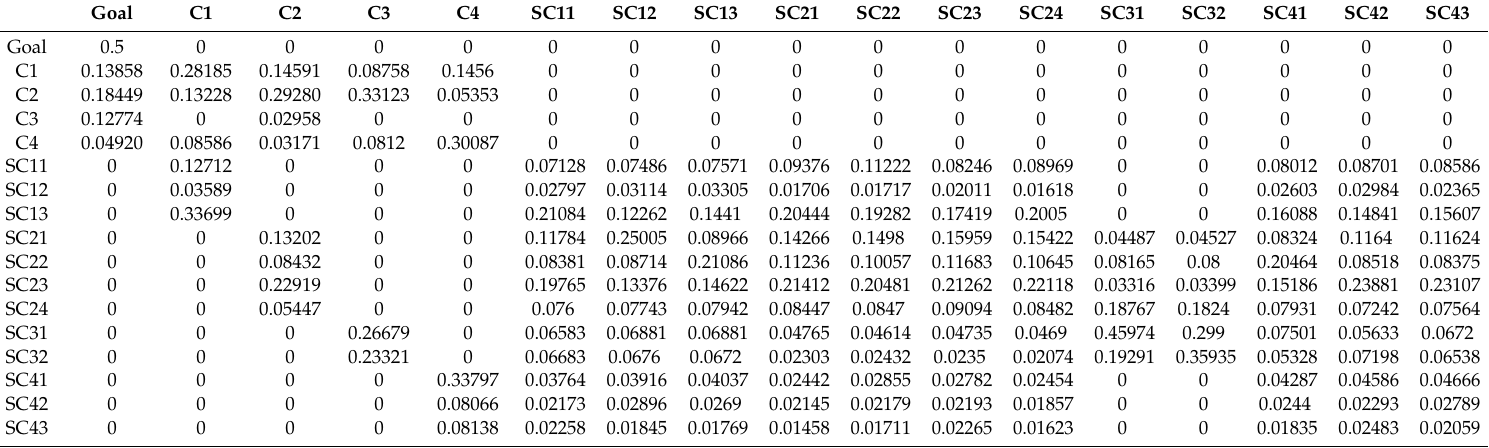
Table 5. Weighted